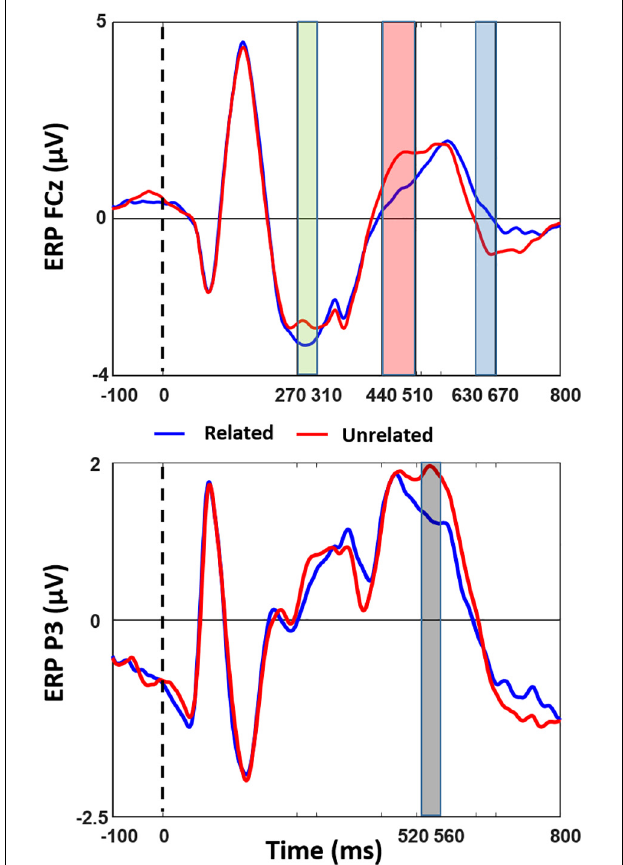
FIGURE 3 | ERP comparison of Semantically Related and Unrelated Distractor conditions. Averaged stimulus-locked ERPs of related and unrelated distractor conditions are shown at illustrative electrodes (FCz and P3). Colors of effects are kept the same as in Figure 2